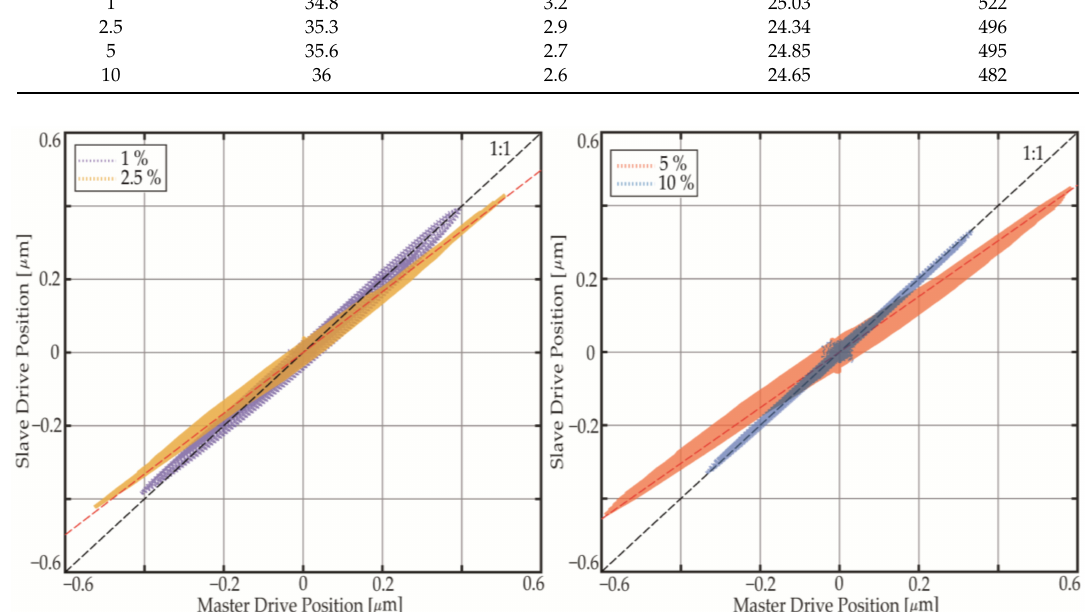
Figure 7. Master and slave displacement ratios due to a disturbance